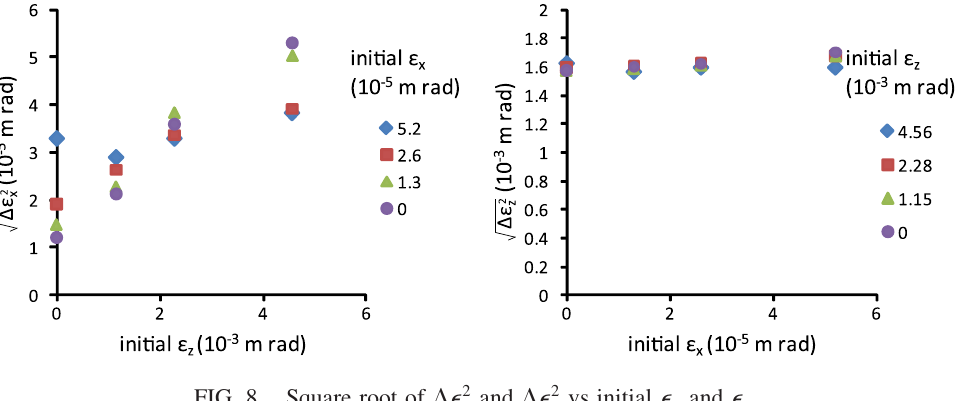
vs initial (cid:1) z